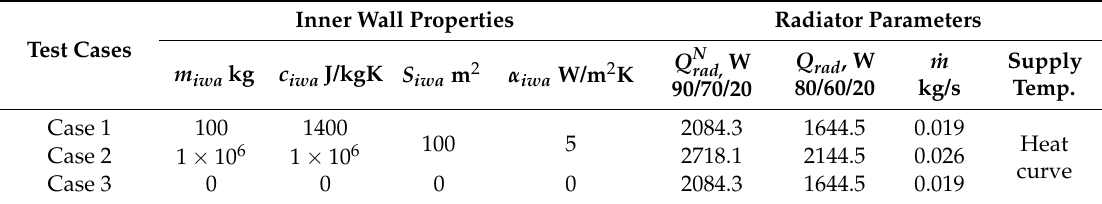
Table 3. Physical properties of inner walls and radiator data for all test